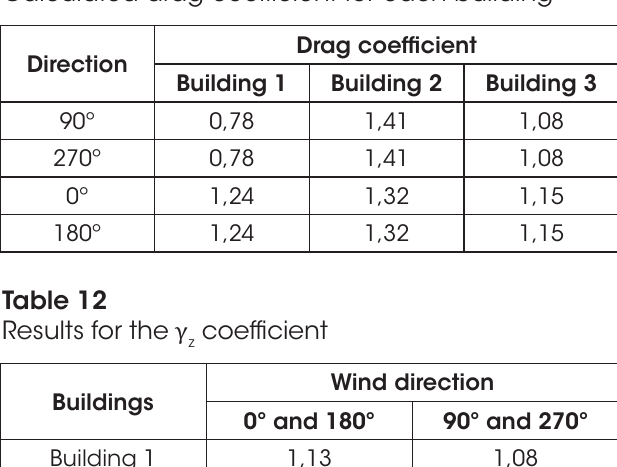
Calculated drag coefficient for each building